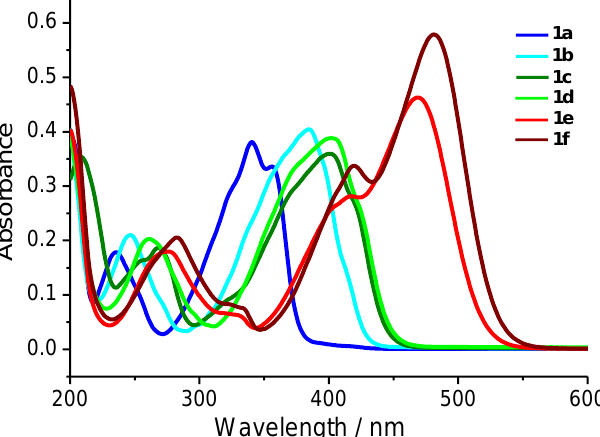
Figure 9. Absorption spectra of dienones 1a – f , in MeCN, C = 1 × 10 − 5 M. Table 4. Parameters of the electronic absorption and fluorescence spectra of dienones 1a – f , MeCN. Dienone